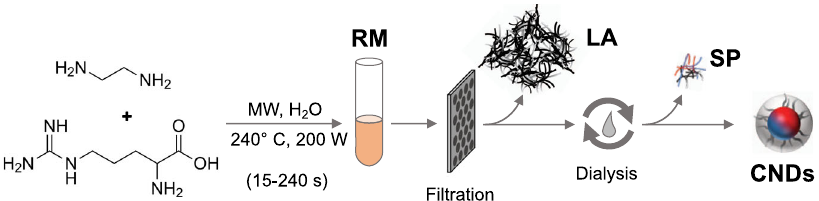
Fig. 1 Scheme of the microwave (MW)-assisted synthetic procedure and work up. Three constituents resulted within the reaction mixture (RM): (i) large aggregates (LA – extracted by fi ltration), (ii) small particles (SP – extracted by dialysis), and (iii) fi nal carbon